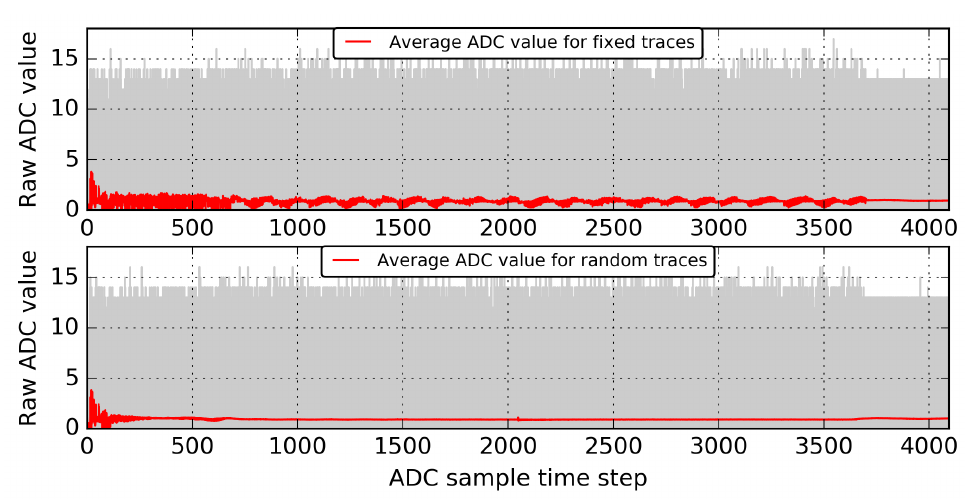
Figure 6: Average over 100k traces for a fixed base exponentiated in a mbedTLS sliding window exponentiation, and 100k traces with each a random base exponentiated with the same secret exponent on the STM32F407VG Discovery #1. ADC connected to GND.